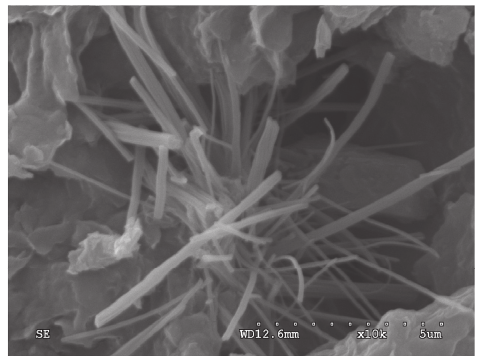
Figure 11: The soil of curing 28d and being magnified 10000 times (1).